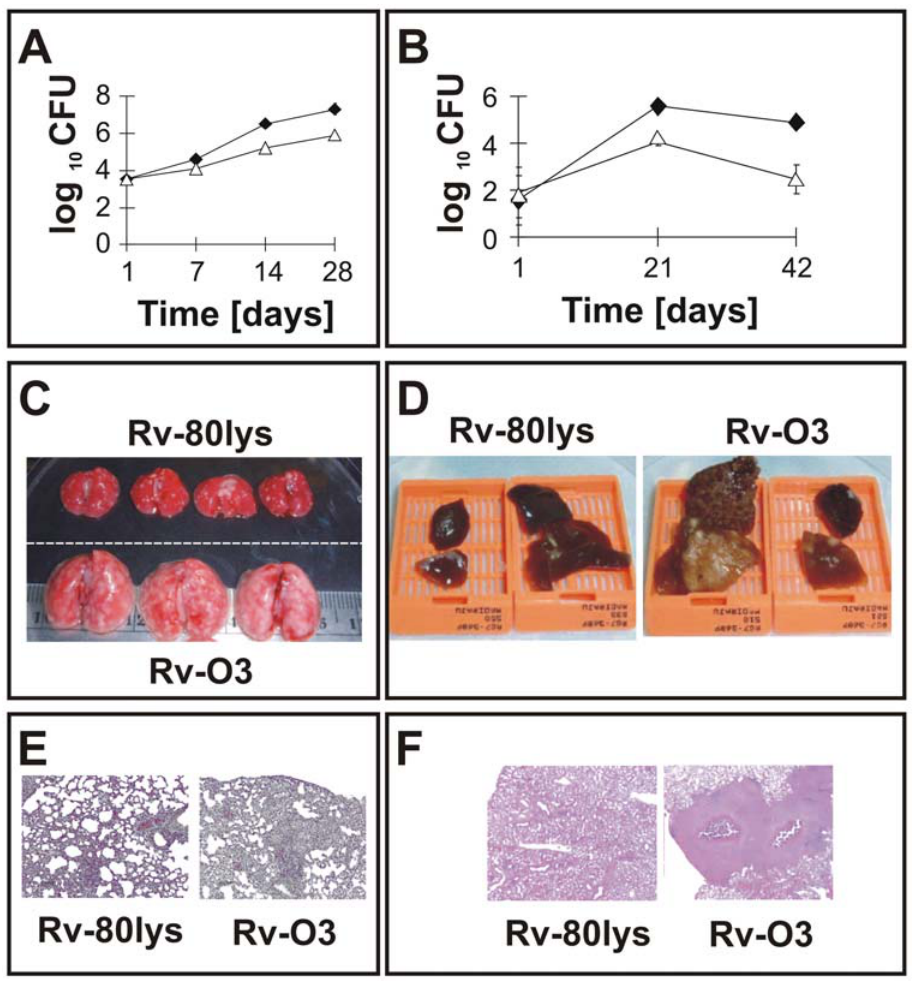
Figure 8. Growth of lysX and WT strains in vivo. Panel A: C57BL/6 female mouse lungs were infected with lysX (triangles) and WT (dark diamonds) strains via an aerosol route. The mean CFU counts were obtained from lung homogenates of at least three mice per group and plated on Middlebrook 7H10 agar plates. All plates were incubated at 37 u C for at least three weeks before colonies were counted. Panel B: Guinea pigs (Hartley strain) were infected with lysX (open symbols) or WT (dark symbols) strains via an aerosol route. Five guinea pigs were sacrificed at days 1, 21 and 42 days after infection, and the survival of Mtb strains in the entire lung homogenate was determined by plating on agar medium as described above. Panels C , D: Gross pathology of the lungs infected with the Rv-80lys and Rv-03 Mtb strains. Lungs from mouse -C- and guinea pig -D- were excised, stored in 10% formalin, embedded, and stained with hematoxylin and eosin for histopathological analysis. Note the presence of tubercles on the surface of the lungs for Rv-03 compared to Rv-80lys. Panels E , F: Histopathology of mouse -E- and guinea pig -F- lungs infected with the Rv-80lys and Rv-03 Mtb strains. Hematoxylin-eosin staining confirmed that the lungs infected with Rv-03, but not those infected with Rv-80lys, had extensive inflammation in both species and showed caseating granulomas in guinea